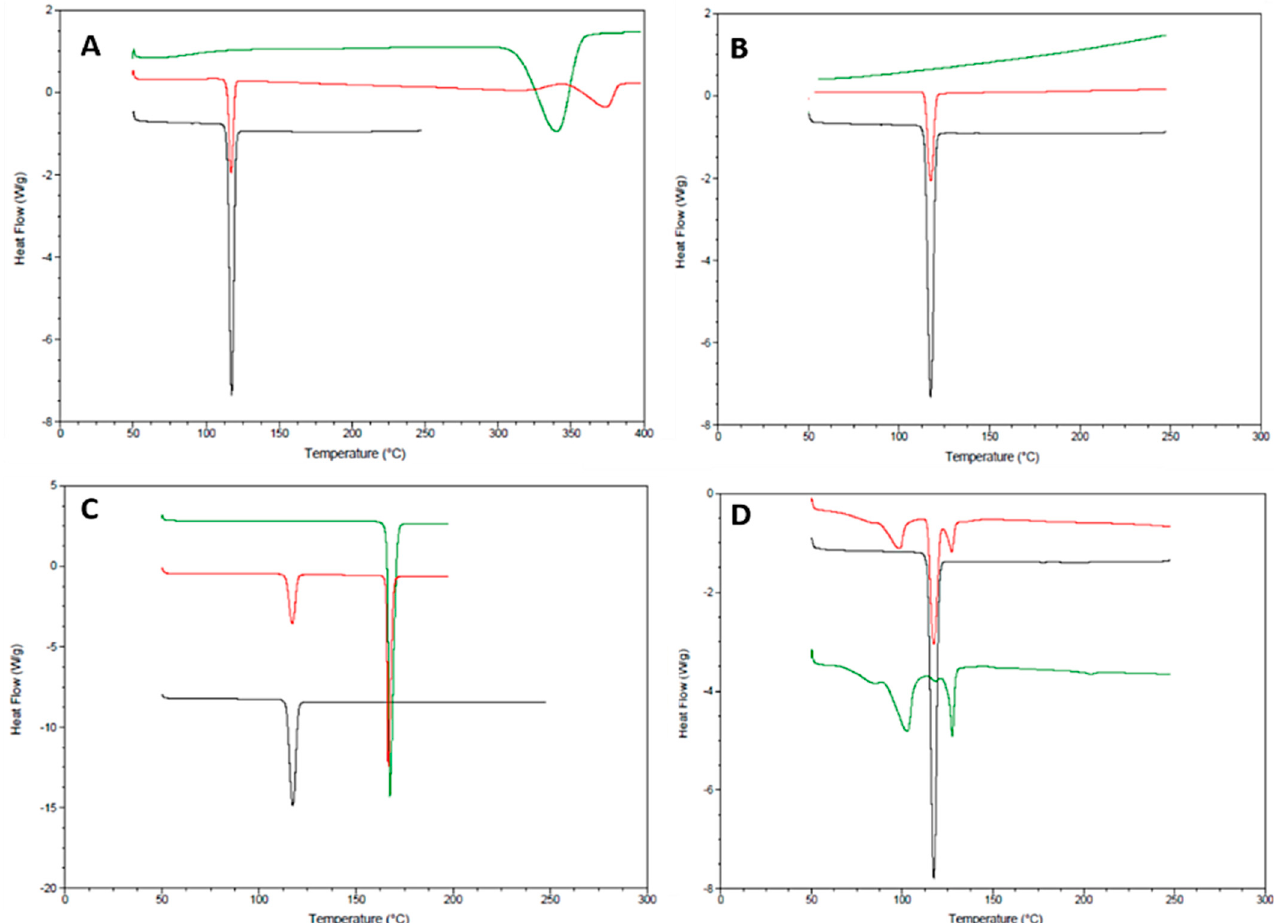
Figure 1. DSC thermograms showing compatibility between carvedilol and selected excipients. ( A ) MCC, ( B ) CSD, ( C ) mannitol, and ( D ) magnesium stearate. In each thermogram, the black, red, and green curves represent carvedilol, the excipient, and a 1:1 of carvedilol and excipient, respectively.